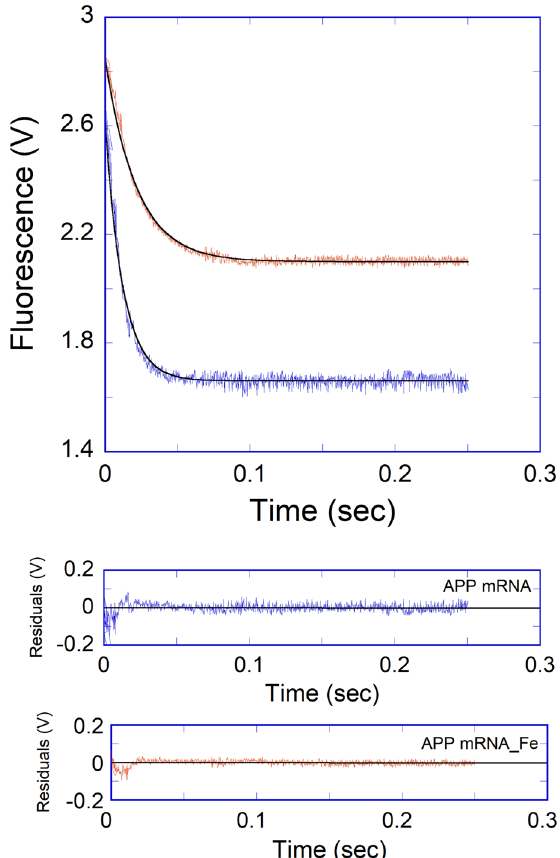
Figure 7. Iron decreases the kinetic rates for the binding of APP IRE mRNA to IRP1. Representative kinetic data show the time-dependent decrease in fluorescence intensity caused by binding of APP mRNA and APP mRNA-Fe 2+ with IRP1. APP mRNA and IRP1 concentration were 500 nM and 100 nM (final), and the Fe 2+ concentration was 50 μM (final). The solid line represents the fitted curve for a single-exponential function. The residual for the exponential fits is shown in lower